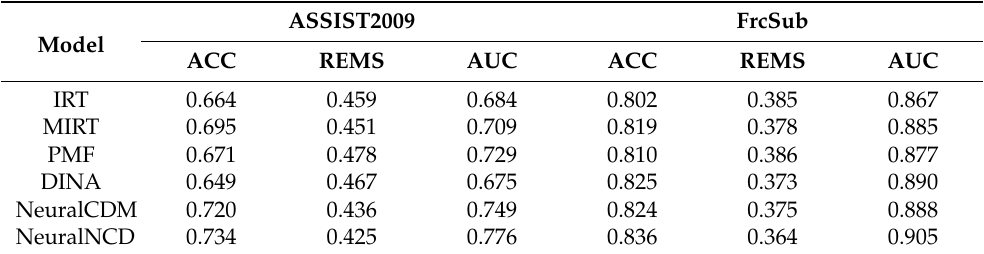
Table 2. Evaluation results of the model on ASSIST2009 and FrcSub datasets.